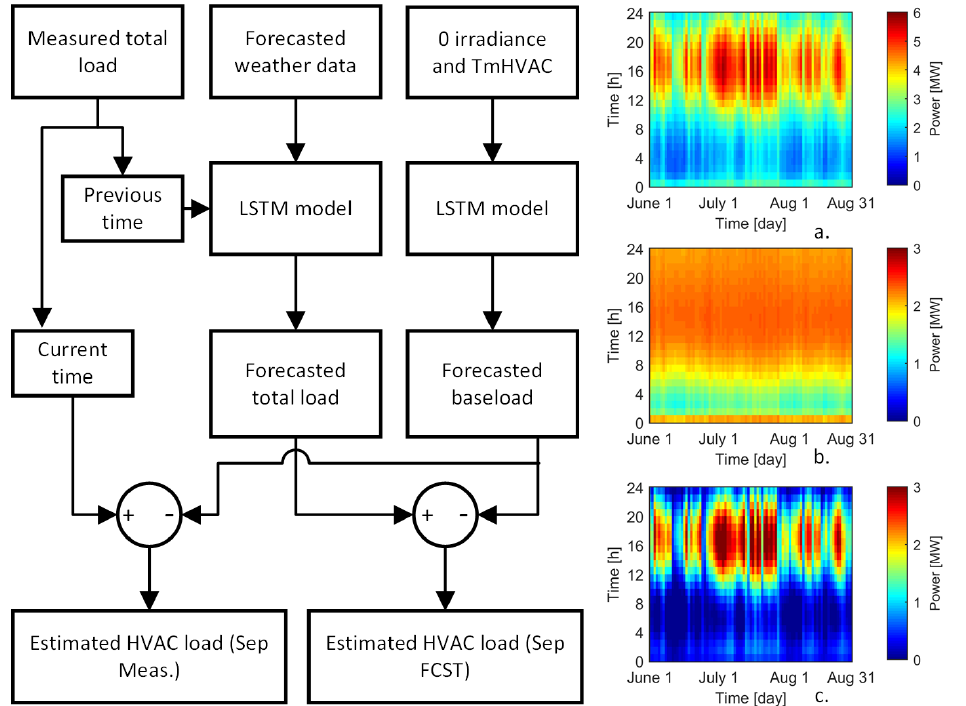
Figure 8. Flow chart of the proposed LSTM-based method for forecasting and dissagregation (in the left). Also included are the total ( a ), baseload ( b ), and separated/dissagregated HVAC power component ( c ) for the example community during the 2020